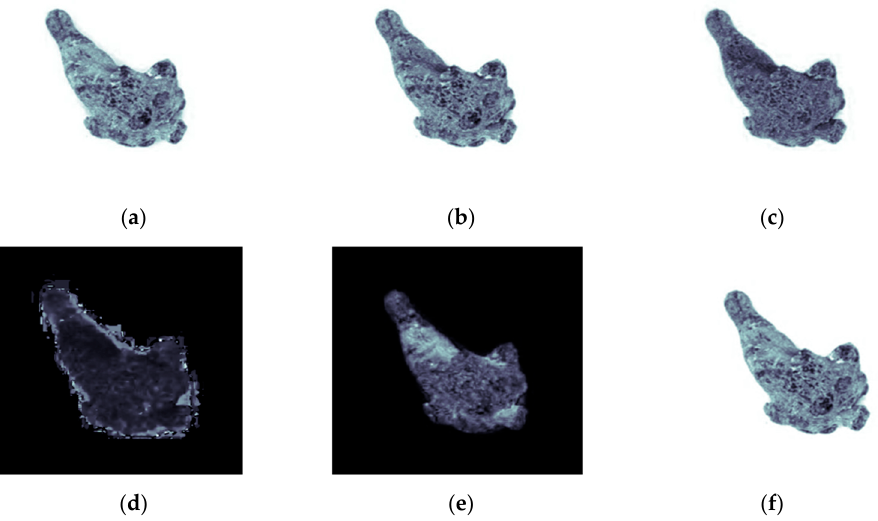
Figure 5. RGB and HSV visualization. ( a ) Red channel (R), ( b ) green channel (G), ( c ) blue channel (B), ( d ) hue (H), ( e ) saturation (S), ( f ) value (V).